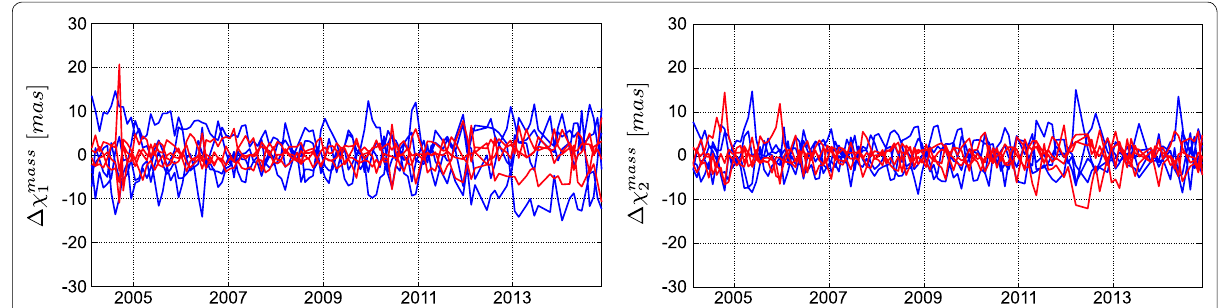
Fig. 5 Differences of the equatorial effective angular momentum functions χ mass 1 and χ mass 2